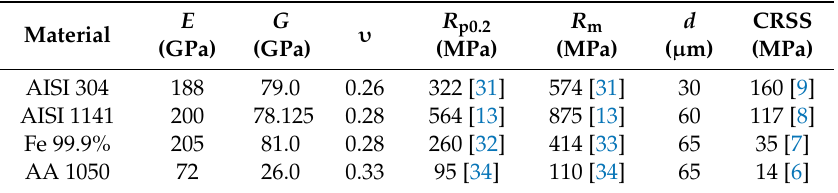
Table 1. Mechanical properties of the considered metals.